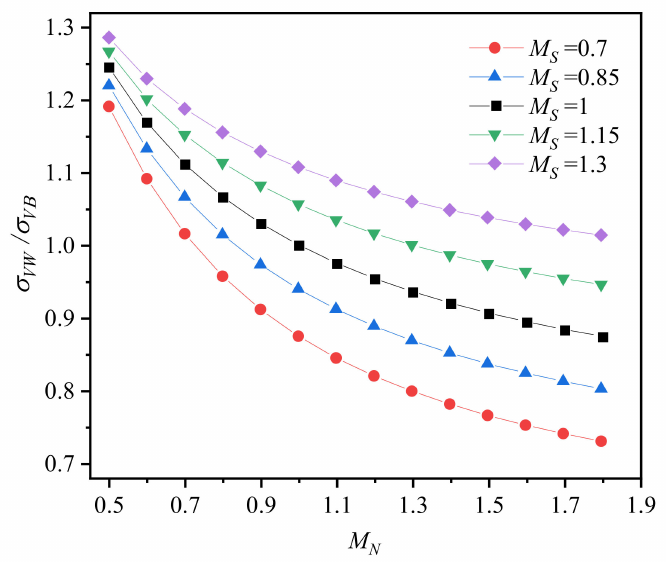
Figure 7. The ratio between Von Mises stress in the weld metal and base